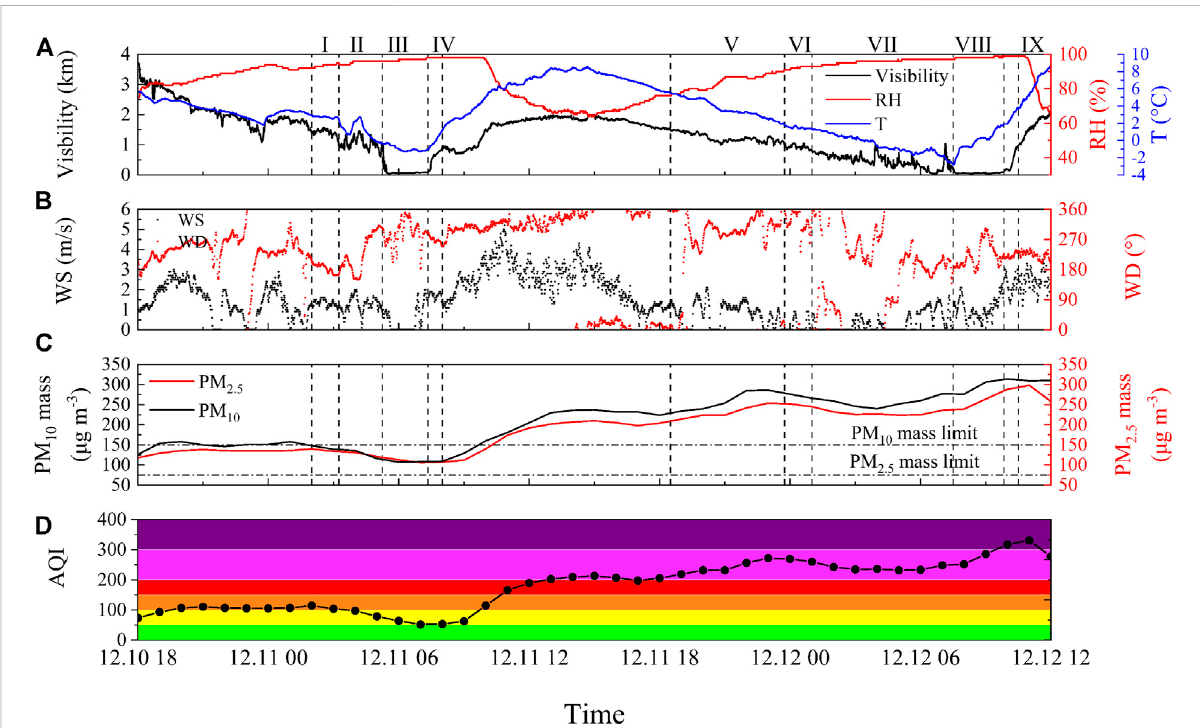
FIGURE 8 Timeseriesof(a)visibility,relativehumidity(RH),ambienttemperature(T),(b)windspeed(WS)andwinddirection(WD),(c)massconcentrations of particles with diameter less than 2.5 and 10 μ m (PM 2.5 and PM 10 ), and (d) air quality index (AQI). I, II, III, and IV correspond to the pre-formation, formation, mature, and dissipation phase of the fi rst fog case, respectively. V, VI, VIII, VIII, and IX correspond to the pre-formation, formation, development, mature, and dissipation phase of the second fog case,